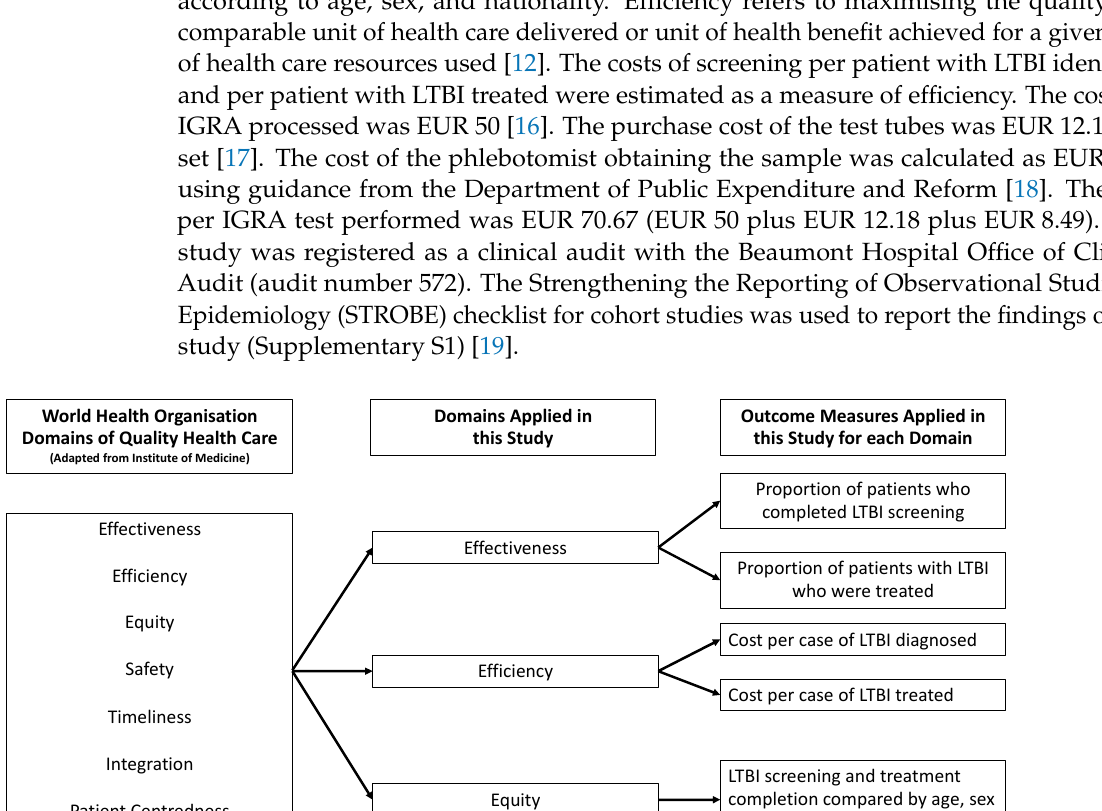
Figure 1. Framework, domains, and measures applied.